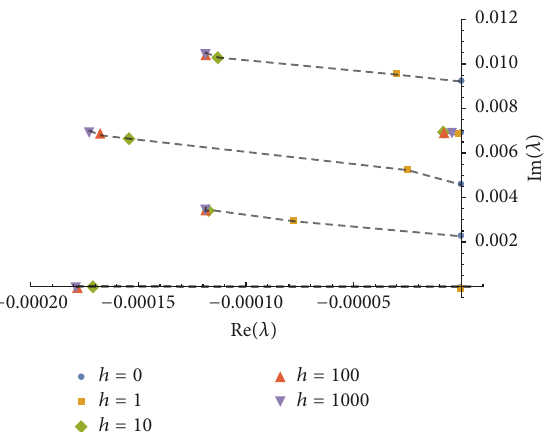
Figure 1: Numerical solutions for the first five eigenvalues above the real axis (there is an infinite sequence going further along the imaginary axis, and they are reflected in the real axis). We use multiplier ℎ to increase 𝑍 , and the real part of each eigenvalue we have followed decreases from 0 as 𝑍 increases from 0.